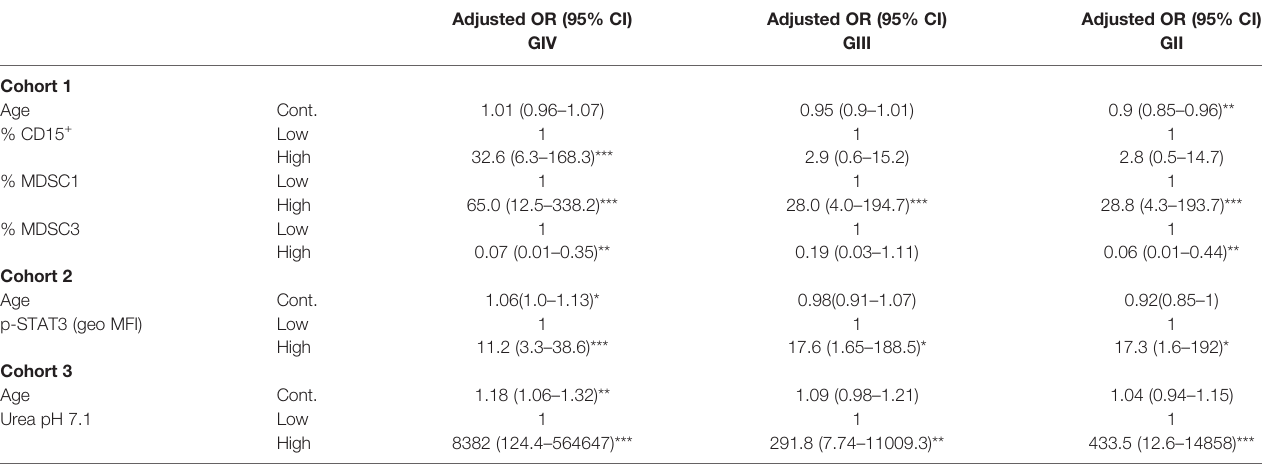
TABLE 3 | Factors for glioma grade risk (multiple analysis with multinomial logistic regression model). Adjusted OR (95%